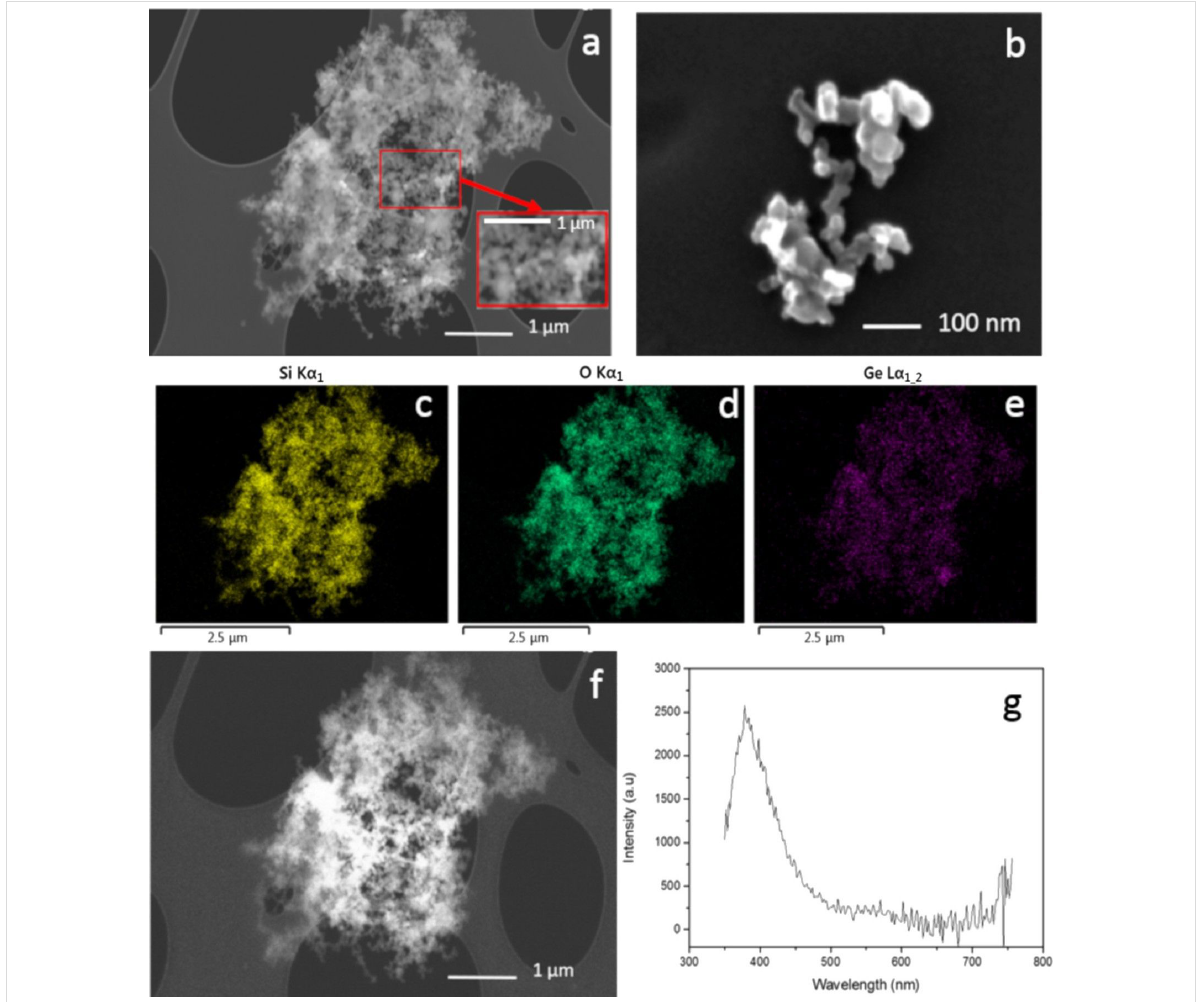
Figure 4: Sample B (SiO 2 +Ge, 165 mJ/pulse); a) SEM image of an aggregate/agglomerate of nanoparticles, inset zoom of the red square; b) SEM image of a small group of nanoparticles; c), d) and e) EDX mapping of the Si K α 1 , O K α 1 and Ge L α 1,2 lines, respectively, acquired for the